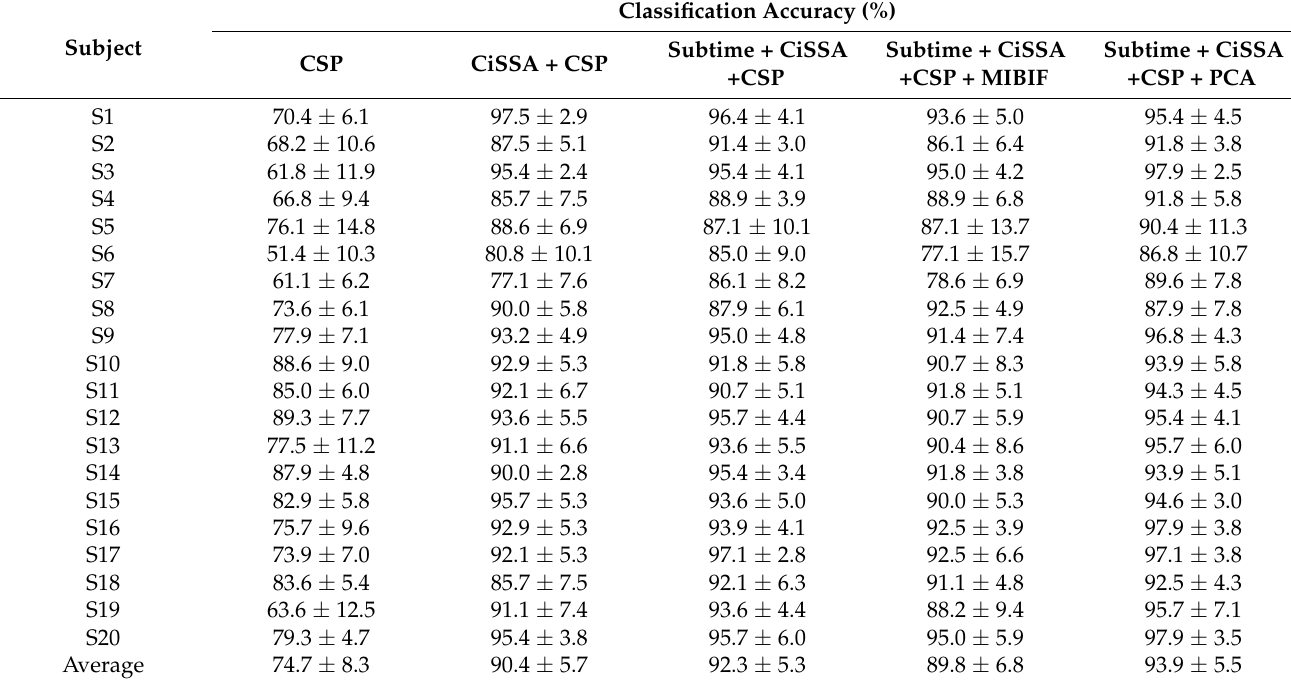
Table 8. The classification accuracies of the proposed CiSSA-CSP method on experimental motor imaginary